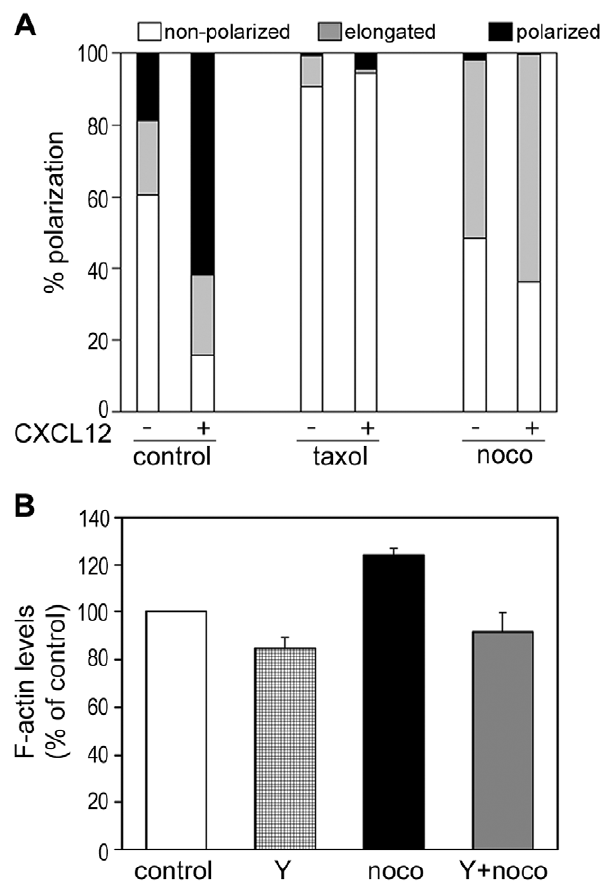
Figure 3. Effects of microtubule-disrupting agents on T-cell polarization and F-actin levels. (A) Quantification of T cell polarization. T cell morphology was classified in 3 categories: 1) non- polarized (white), where the cells had a spherical morphology, 2) elongated (gray), where the cells had an elongated cell shape but no diametric polarization of F-actin and a -tubulin, and 3) migratory polarized (black), where the cells were elongated and had diametric distribution of F-actin at the leading edge and the MTOC (identified with anti- a -tubulin antibody) behind the nucleus; n=110 to 150 cells for each condition from 3 independent experiments. (B) Nocodazole alters F-actin levels in T cells. Flow cytometric analysis of the F-actin content of CCRF-CEM cells incubated with 10 m M Y-27632 for 30 min and/or 20 m M nocodazole for 10 min. Data are shown as a percentage of the mean fluorescence of untreated cells. Data are the mean of three independent experiments + / 2 SEM. *p , 0.05 compared to control cells.